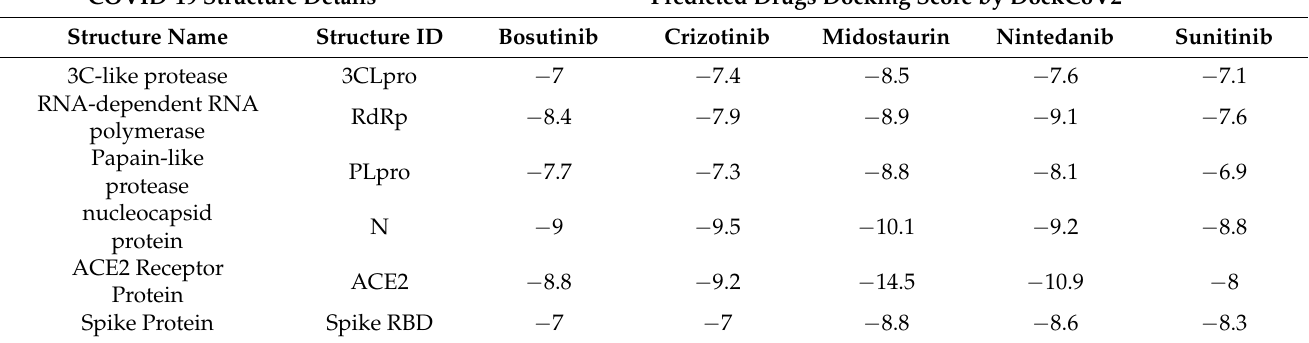
Table 4. Docking scores of top five potential actionable COVID-19 repurposed drugs with COVID-19 protein structures. The top five potential actionable COVID-19 repurposed drugs are also docked with the available COVID-19 proteases like 3CLpro, RdRp, PLpro, N, ACE2, and Spike RBD by DockCoV2. The docking score represents how well these drugs can be docked with COVID-19 proteases. More negative value highlights a good docking that represents that the drug and protease can dock well with each other by using less energy.